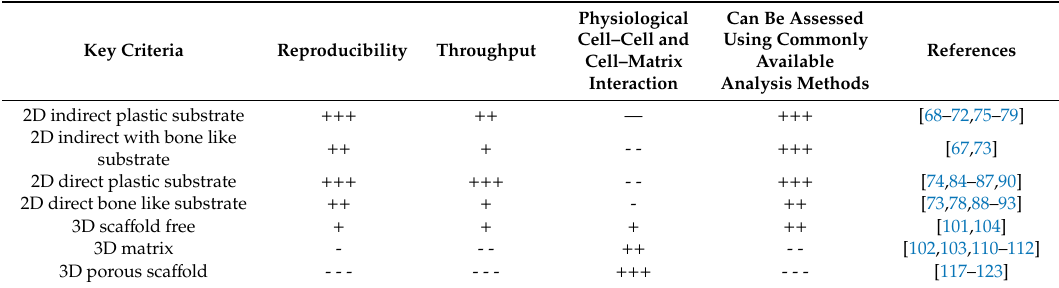
Table 3. Key criteria for preclinical drug testing models. Legend: +++ meets key criterion; ++ partially meets key criterion; + meets key criterion to some degree; - minor limitations regarding criterion; - - more significant limitations regarding criterion; - - - does not meet key